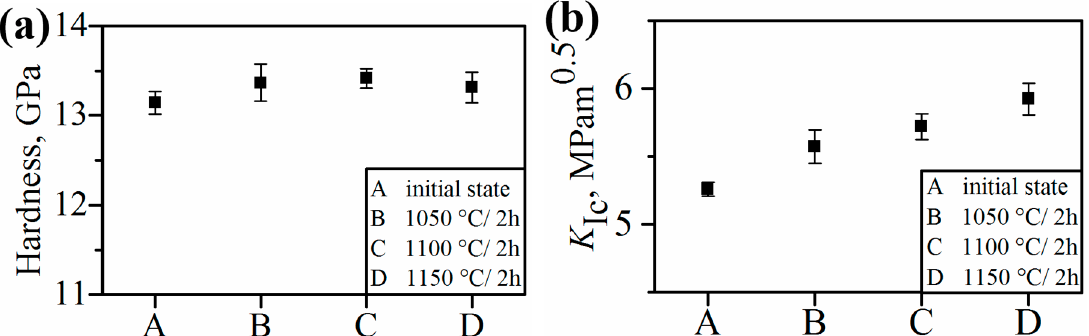
Figure 7. Hardness ( a ) and fracture toughness ( b ) of the TZP layer.